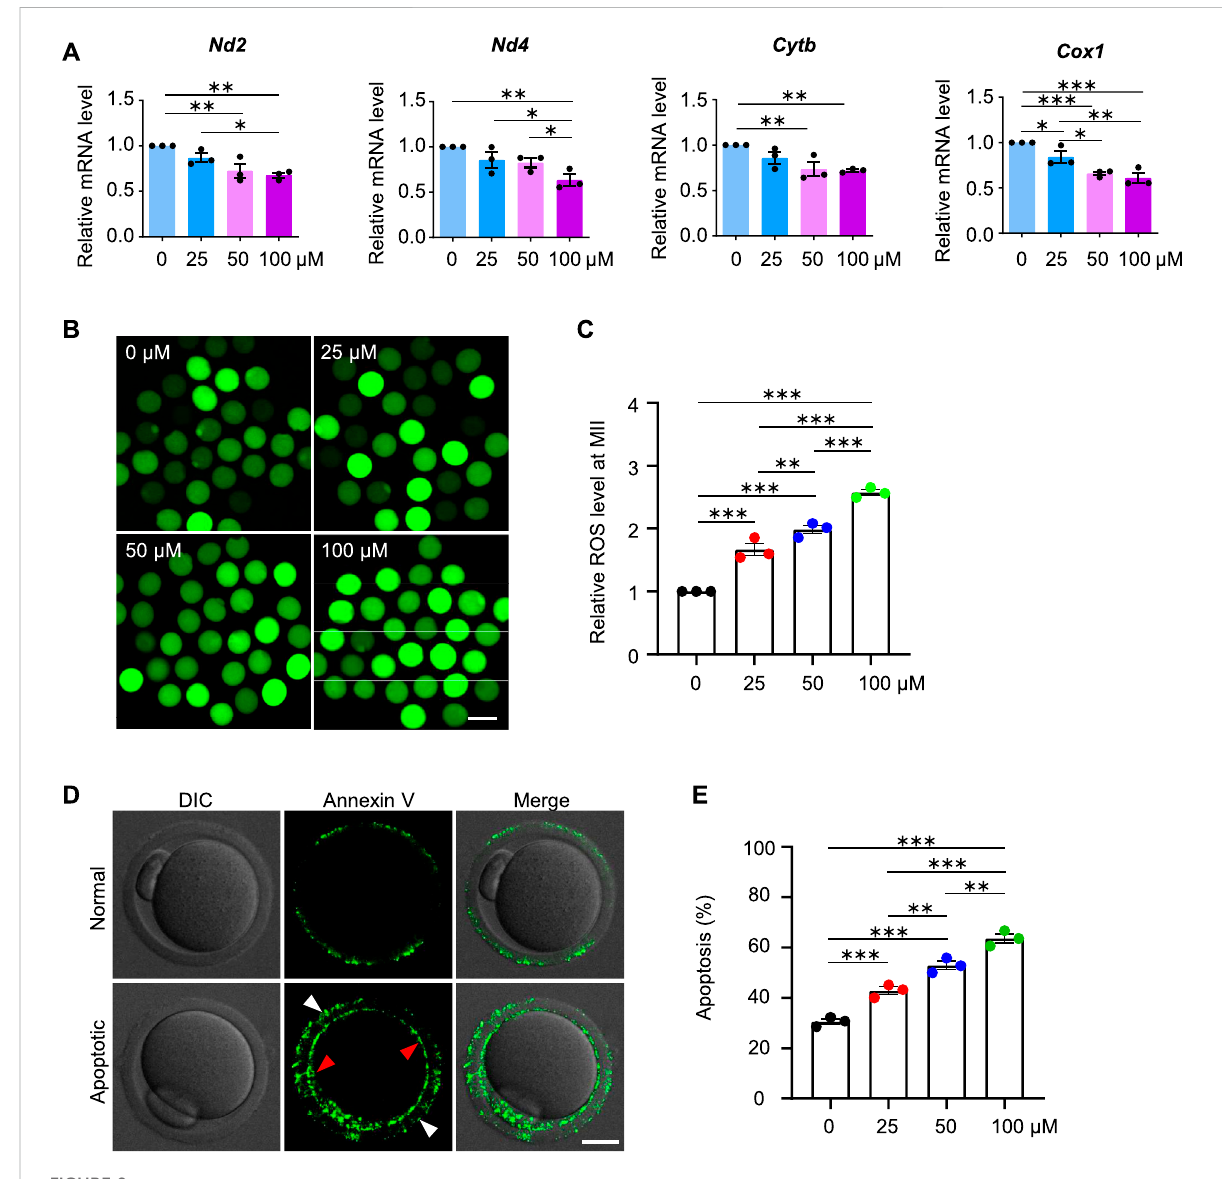
AAI exposure increases intracellular ROS levels and inducesearly apoptosis inmouseMIIoocytes. (A – E) The GVoocyteswerematured for 12 h toreachMIIintheM16mediumwith0,25,50,and100 μ MAAI.Relativeexpressionlevelsofselectedgenesassociatedwithmitochondrialrespiratory chain in MII oocytes by RT-qPCR (A) . ROS levels in MII oocytes were examined with the reliable DCFH-DA probe (B) . Quanti fi cation of (B) showing the relative ROS level (C) . Representative images showing Annexin V staining of MII oocytes from different treatments (D) . Quanti fi cation of (D) showing the percentage of apoptosis (E) . Scale bar, 100 μ m in (B) ; 20 μ m in (D) . Error bar, mean ± SEM of 3 independent experiments. 25 oocytes were used for each experiment per treatment, and totally 75 oocytes were used for each treatment (A) . ~25 oocytes per treatment in each experiment and totally 73, 76, 79, and 85 MII oocytes were used for each treatment, respectively (C) . 30 – 35 oocytes per treatment in each experimentand totally 92, 91, 100, and 102 oocytes were used for each treatment (E) . Only comparisons with signi fi cant differences were indicated; *, p < 0.05; **, p < 0.01; ***, p < 0.001; one-way ANOVA and the LSD test (C,E)